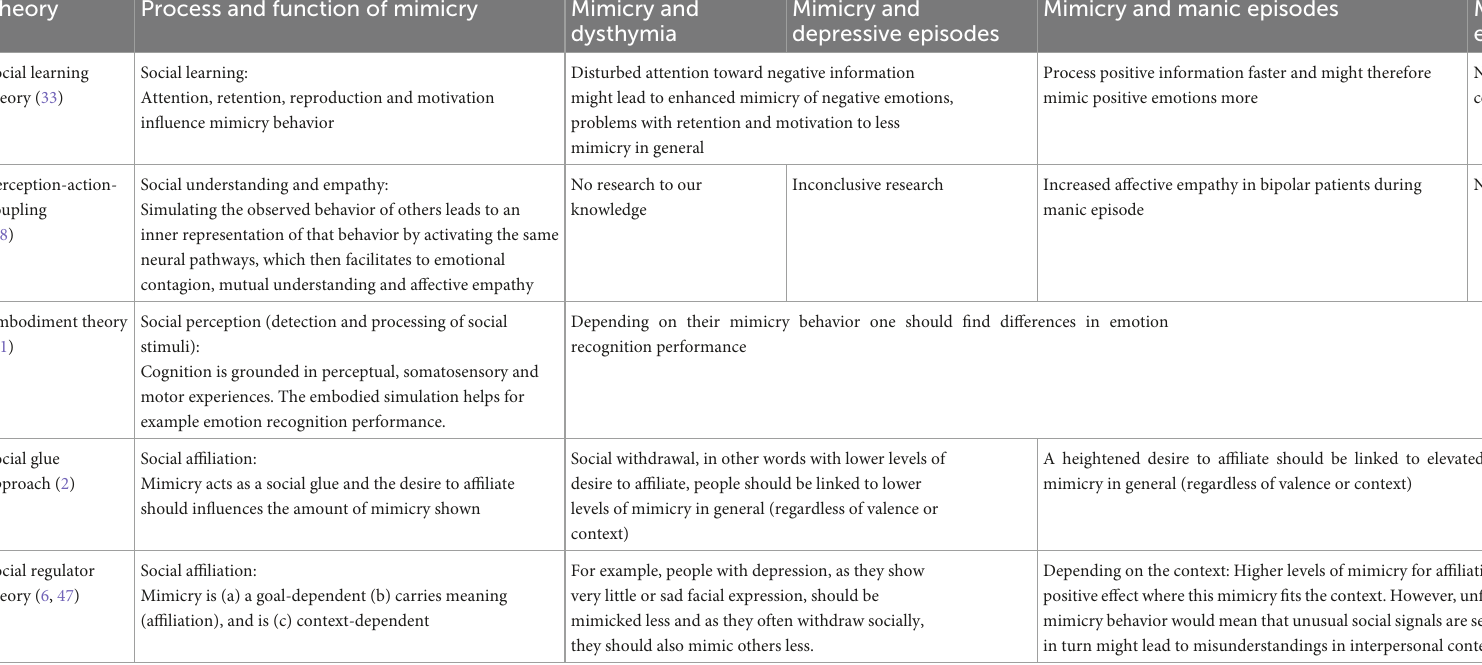
TABLE 1 Theoretical overview on mimicry and affective disorders.